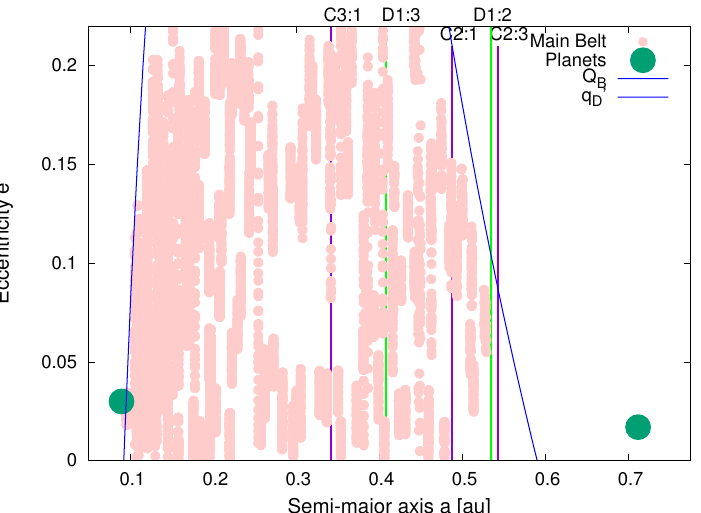
Figure 9. Orbital evolution of the Luyten main asteroid belt (semi-proper elements) in the phase planes a − e and a − i . The vertical lines are the two main mean motion resonances with the planet Luyten D and Luyten E. Note the presence of a ’hole’ in the central zone between 0.26–0.34 au in semi-major axis, and eccentricity 0.05 < e < 0.12. This is likely due to the combination of a secular resonance and the C3:1 mean motion